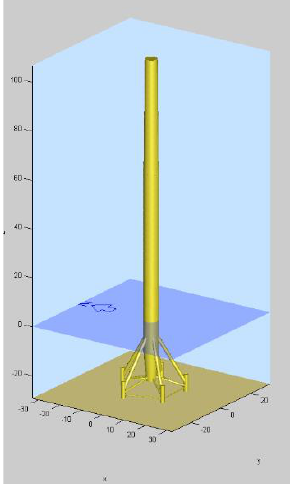
Figure 5. Analysis target.